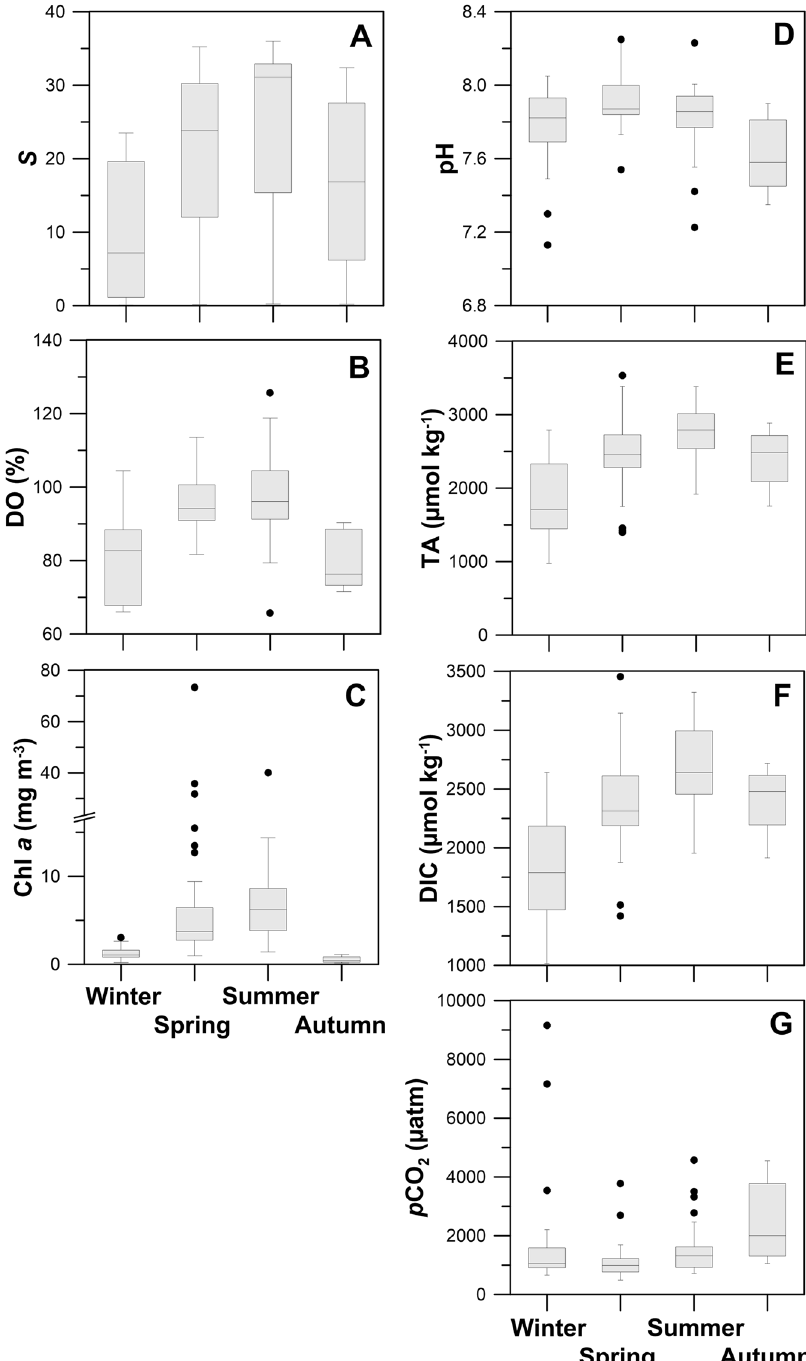
Figure 3. Box-whisker plot of ( A ) salinity ( S ), ( B ) dissolved oxygen (DO), ( C ) chlorophyll a (Chl a ), ( D ) pH, ( E ) total alkalinity (TA), ( F ) dissolved inorganic carbon (DIC) and ( G ) CO 2 partial pressure ( p CO 2 ) in Tagus estuary during 1999–2007. Median values are represented by line inside boxes, 25th to 75th percentiles are denoted by box edges, 10th to 90th percentiles are depicted by the error bars, and outliers are indicated by